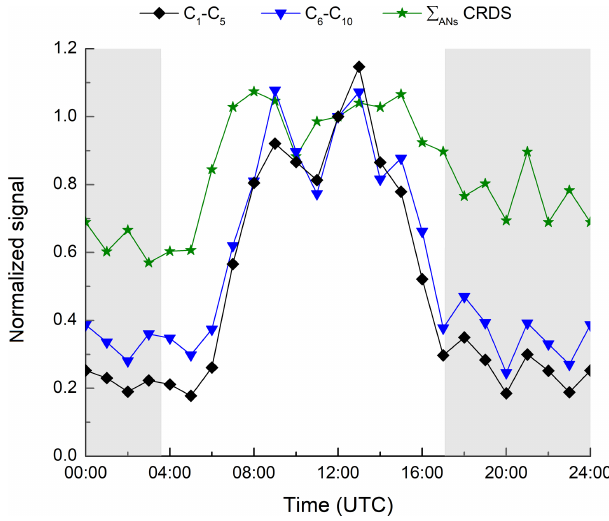
Figure 8. Relative diel profile of HR-L-ToF-CIMS signals at- tributed to C1–C5 and C6–C10 organic nitrates and compari- son with (cid:54) ANs measured by the TD-CRDS. Data normalized at